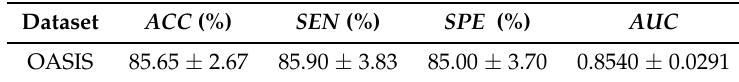
Table 12. Classification performance of MVMM on OASIS dataset.